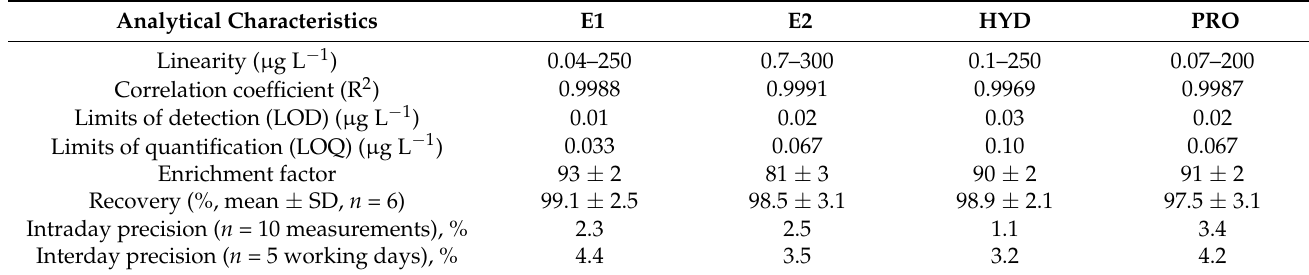
Table 2. Analytical performance of the developed preconcentration method.